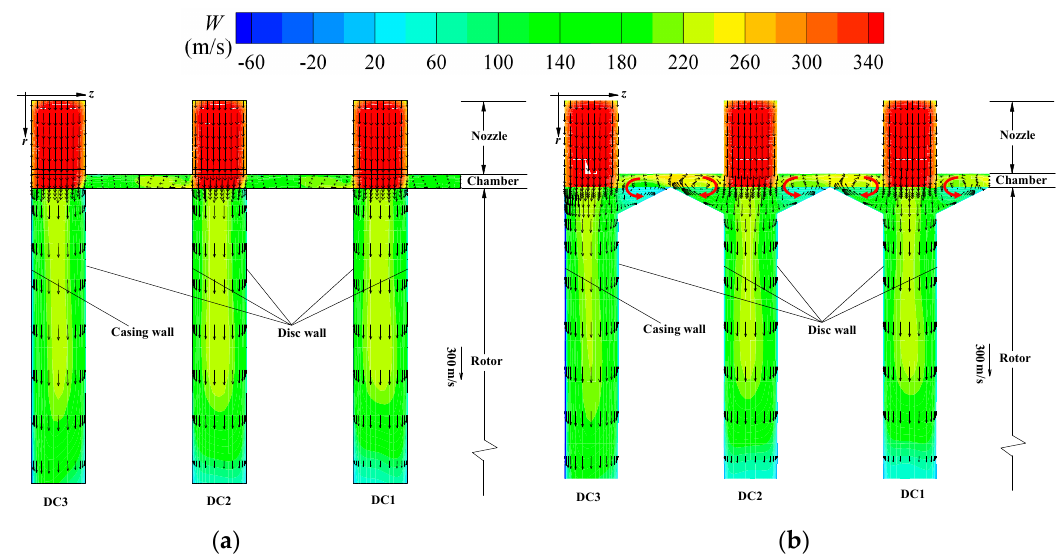
Figure 10. Vectors and relative tangential velocity distributions on the radial section of 0 ° for two turbine models. ( a ) OTO-B; ( b ) OTO-T-2.